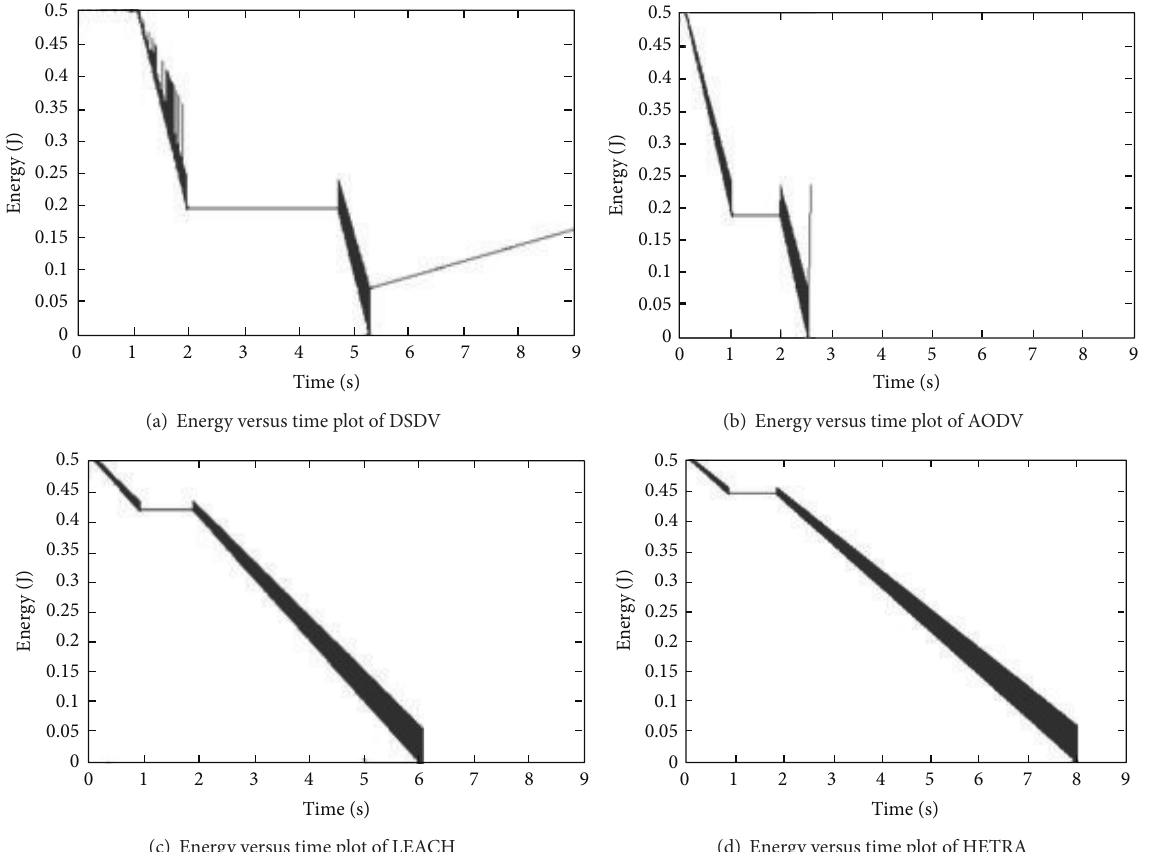
Figure 5: Remaining energy of ALL pattern sensor nodes with different routing algorithms and TCP/EXP.